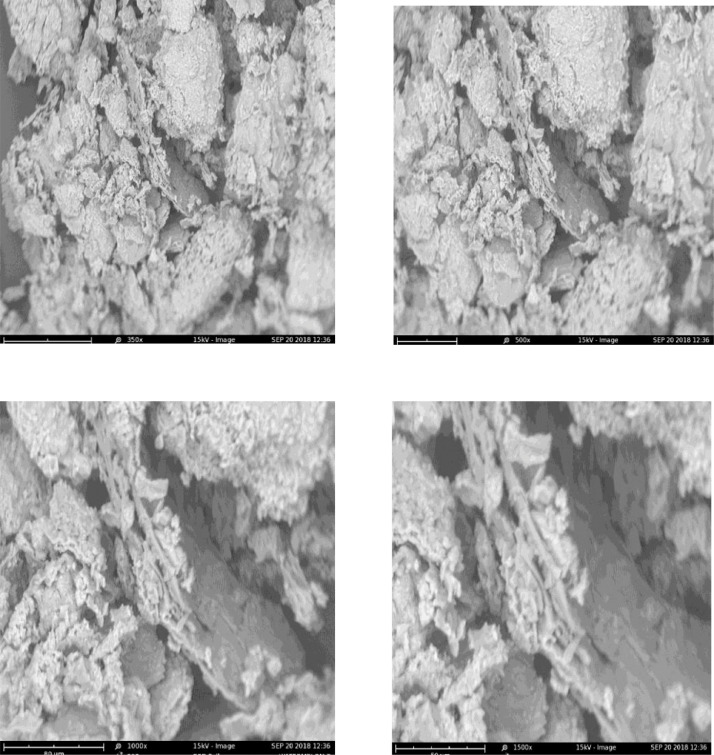
(a) SEM image of a catalyst at different magnification. (b) FTIR analysis of the catalyst.